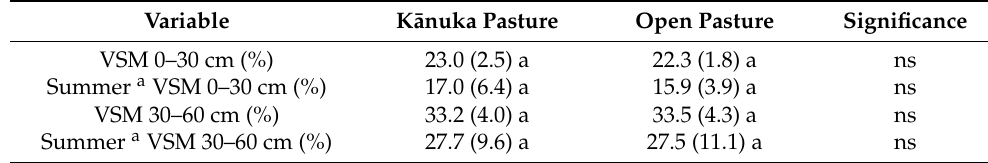
Table 4. Volumetric soil moisture (VSM) for the treatments averaged between sites. The standard error of the mean is given in